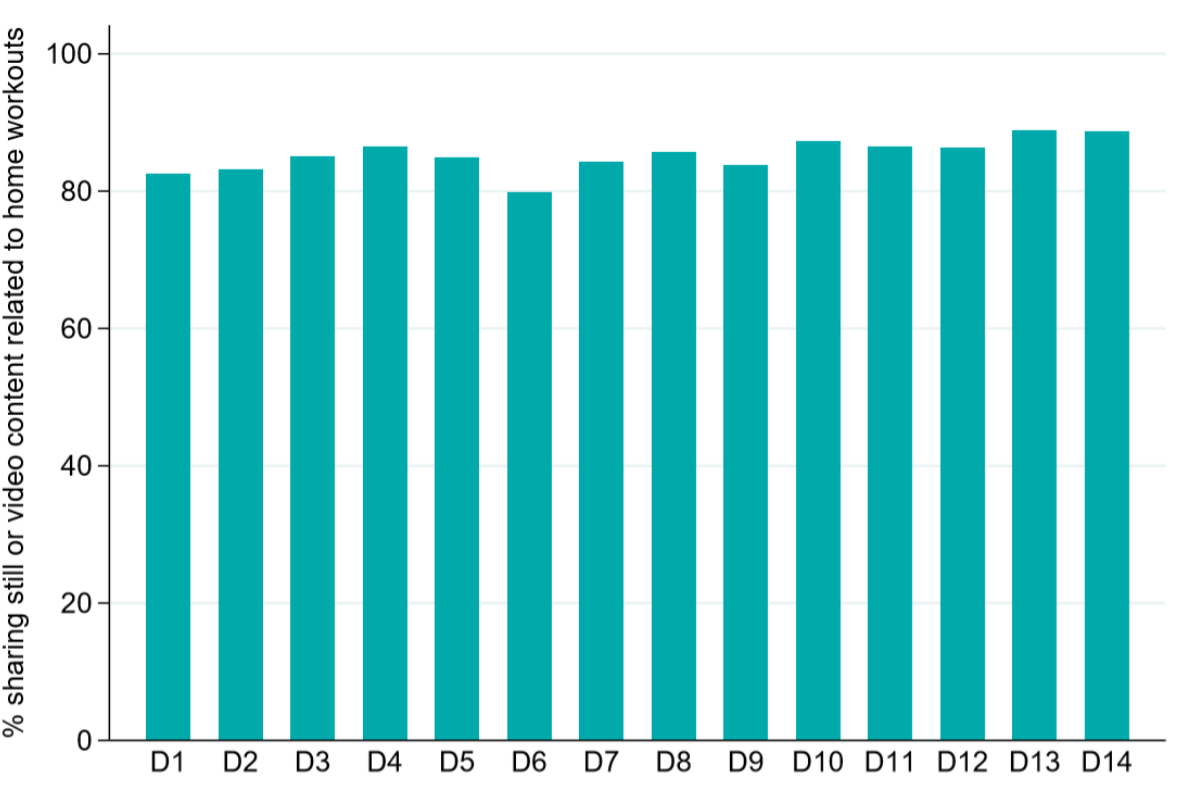
Figure 2. The proportion of participants sharing photos or video content related to home workouts in the intervention